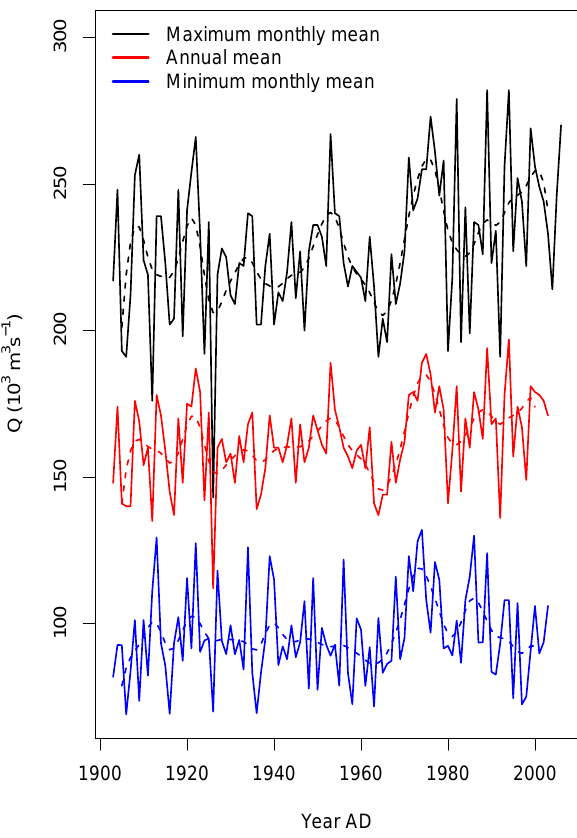
Fig. 4. Maximum monthly (black), minimum monthly (blue), and annual mean (red) river discharge at Obidos measured by Hydro- logical Service ANA, Brazil, http://www2.ana.gov.br/, and, where measurements are missing, estimated from upstream river gauge stations by Call`ede et al. (2004), based on data from the same data-